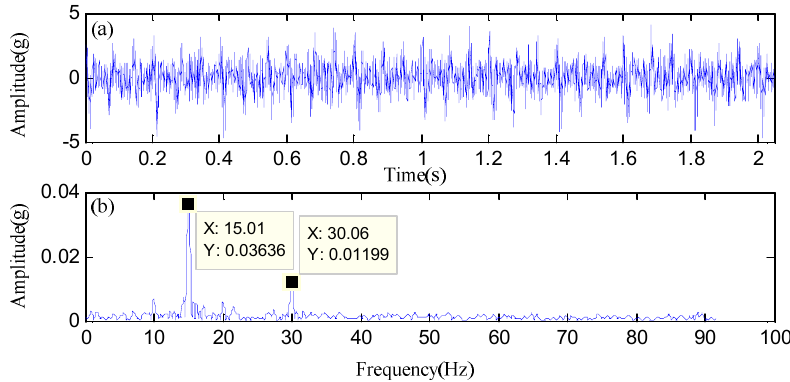
Figure 4. Filtering results of MED. ( a ) Time domain signal. ( b ) Envelope spectrum.